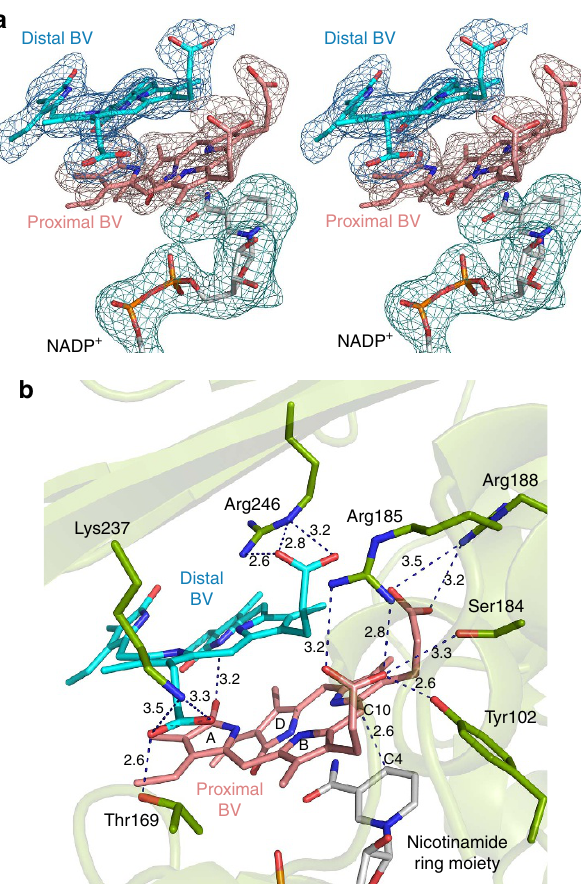
Figure 5 | The binding modes of the BVs and NADP þ in Syn BVR. ( a ) Stereo view of the electron density map around the bound two BVs and NADP þ in the Syn BVR. An omit F o – F c difference map for BVs (blue and salmon pink) and NADP þ (cyan) contoured at 2.0 s is overlaid on the stick models of the bound BVs and the bound NADP þ . The view direction is same as in right panel in Fig. 2. ( b ) The environment around the bound two BVs in the Syn BVR. The bound BVs, NADP þ and the residues involved in the BV binding are shown with the stick. Dashed lines indicate hydrogen